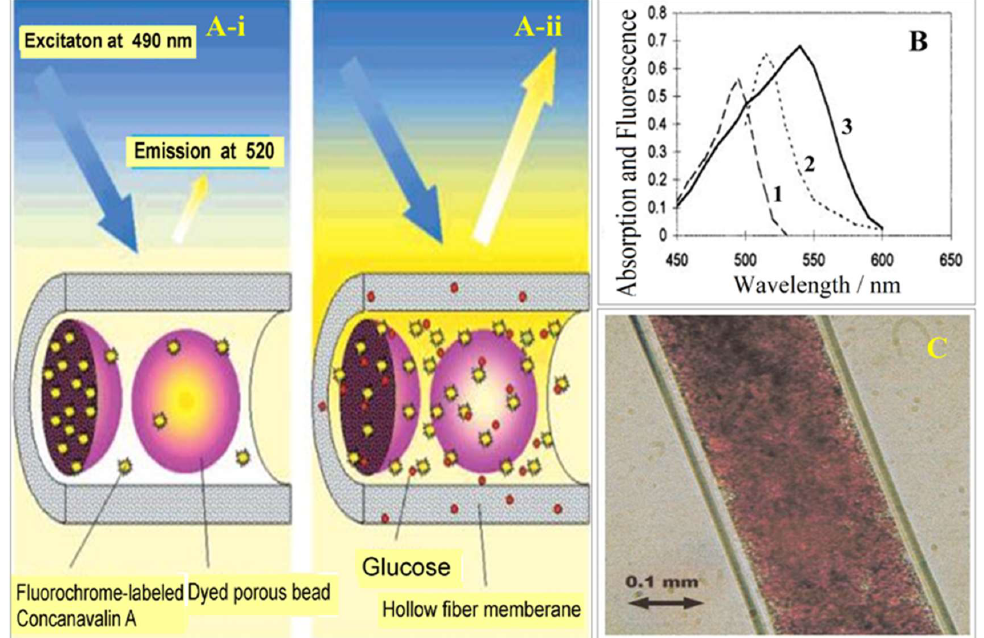
Figure 20. ( a ) Schematics illustrating the principles of the fluorescence affinity hollow fiber sensor. In the absence of glucose, fluorochrome-labeled Concanavalin A is bound to the fixed glucose residues inside the porous beads ( A ( i )). The beads are colored with dyes that prevent the excitation light from inducing Con A to fluoresce, keeping the fluorescence emission at 520 nm. After diffusion of glucose through the hollow fiber membrane (molecular weight cutoff, 10 kDa), Con A is displaced from the beads and diffuses out of them. Fluorochrome-labeled Con A becomes exposed to excitation light, resulting in a strong increase in fluorescence ( A ( ii )). ( b ) Spectra of fluorescence and absorption of the various chromophoric components of the bead-based affinity sensor. (1) Excitation spectrum of fluorescein, (2) emission spectrum of fluorescein, (3) absorption spectrum of dye-labeled Sephadex beads. ( c ) Light microscopy picture of a small section of the hollow fiber that was filled with dye-colored Sephadex G150 beads. A bead fraction having a bead diameter of less than 25 µm was used in this study; the beads were obtained by sieving the original material (mesh size of 25 µm) [58].